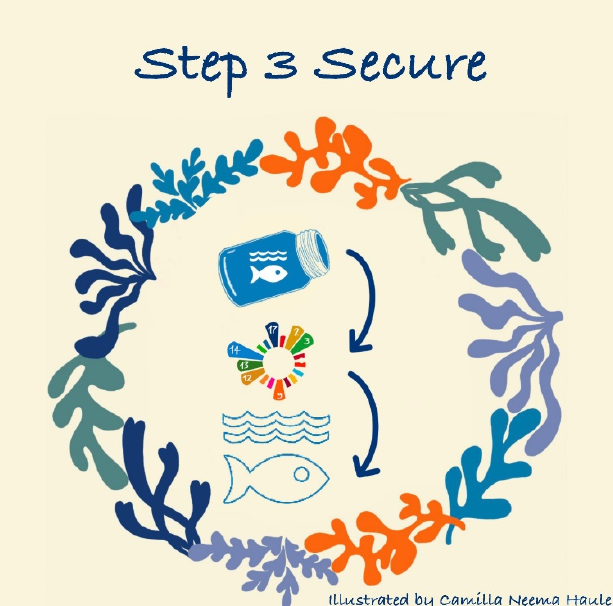
Figure 3. The systematic approach of the Agenda 2030 applied to ocean plastics: overcoming loopholes in regulation through a multilevel governance system applied to the SDG 14, on Life Below Water [41,42]. Illustration by Camilla Neema Haule for SECURE 2021.